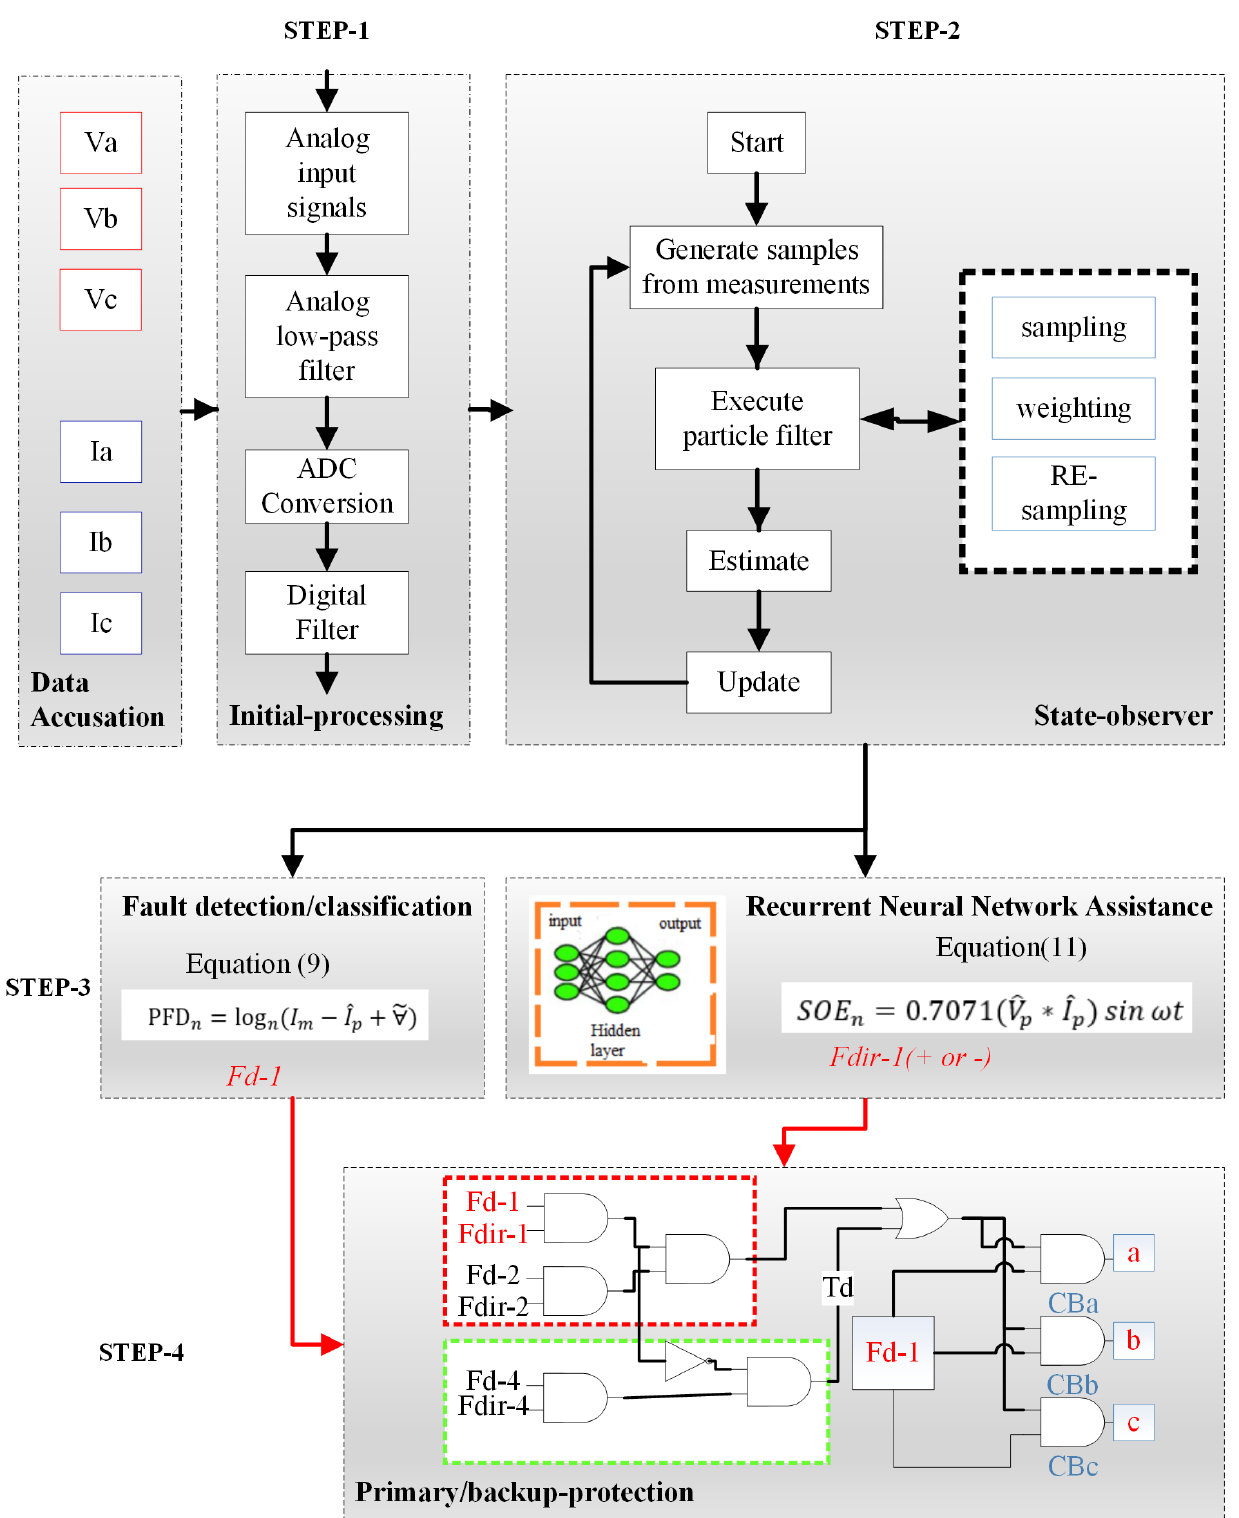
Figure 3. Schematic demonstration of proposed state-observer-based protection scheme, where a, b, and c represented the